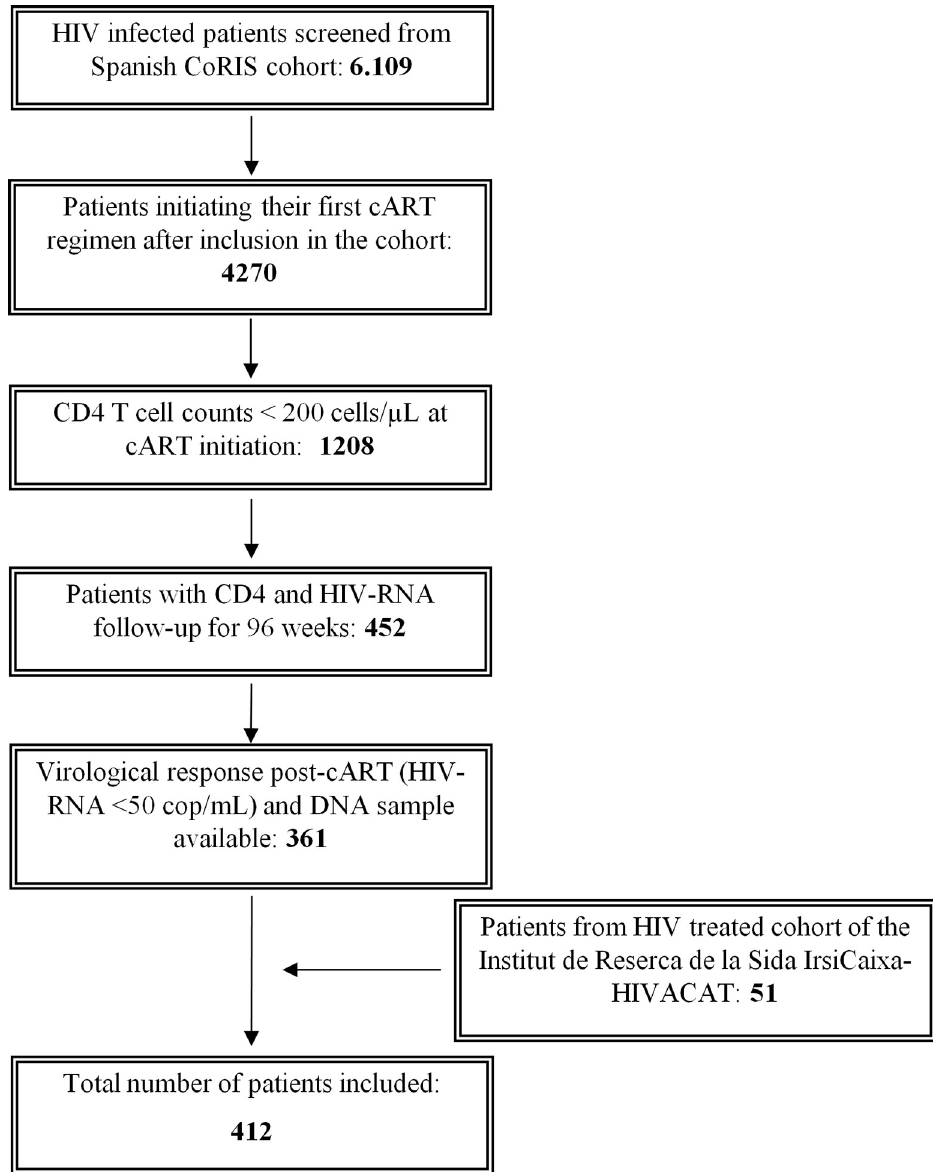
Fig 1. Flow chart of inclusion criteria of patients. Flow chart showing the inclusion criteria and the sequential strategy of selection of patients included in the study. Numbers inside the boxes indicate the number of patients selected after each step in the selection